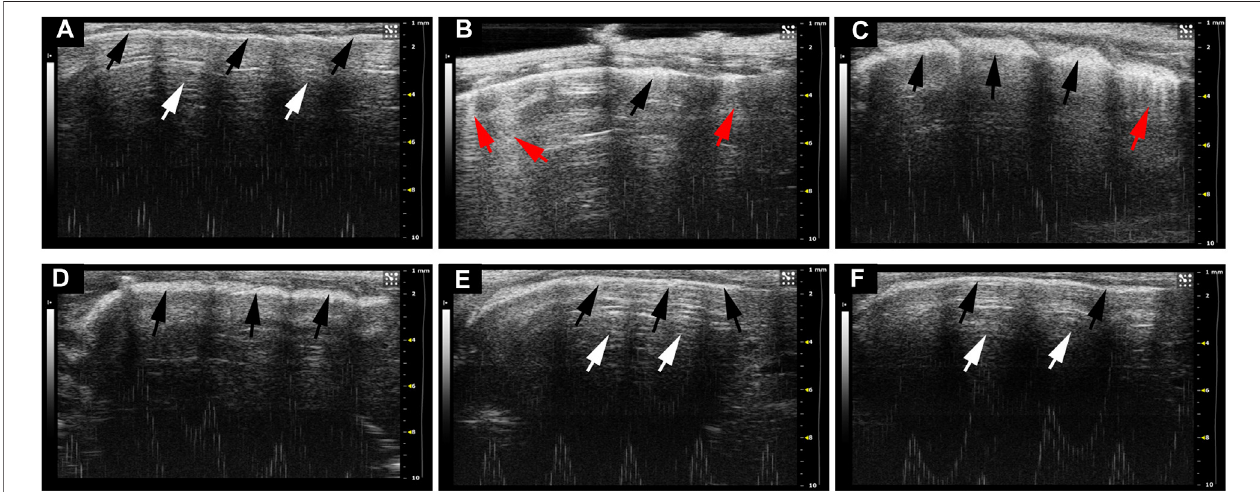
FIGURE 2 | The ultrasound imaging lesions of ARDS were evaluated by lung ultrasound. (A) Control group: (B) LPS+PBS group; (C) LPS+2.6 g/kg NFPX group; (D) LPS+5.2 g/kg NFPX group; (E) LPS+10.4 g/kg NFPX group; (F) 10.4 g/kg NFPX group. White arrow: A-lines; red arrow: B-lines; black arrow: pleural line.